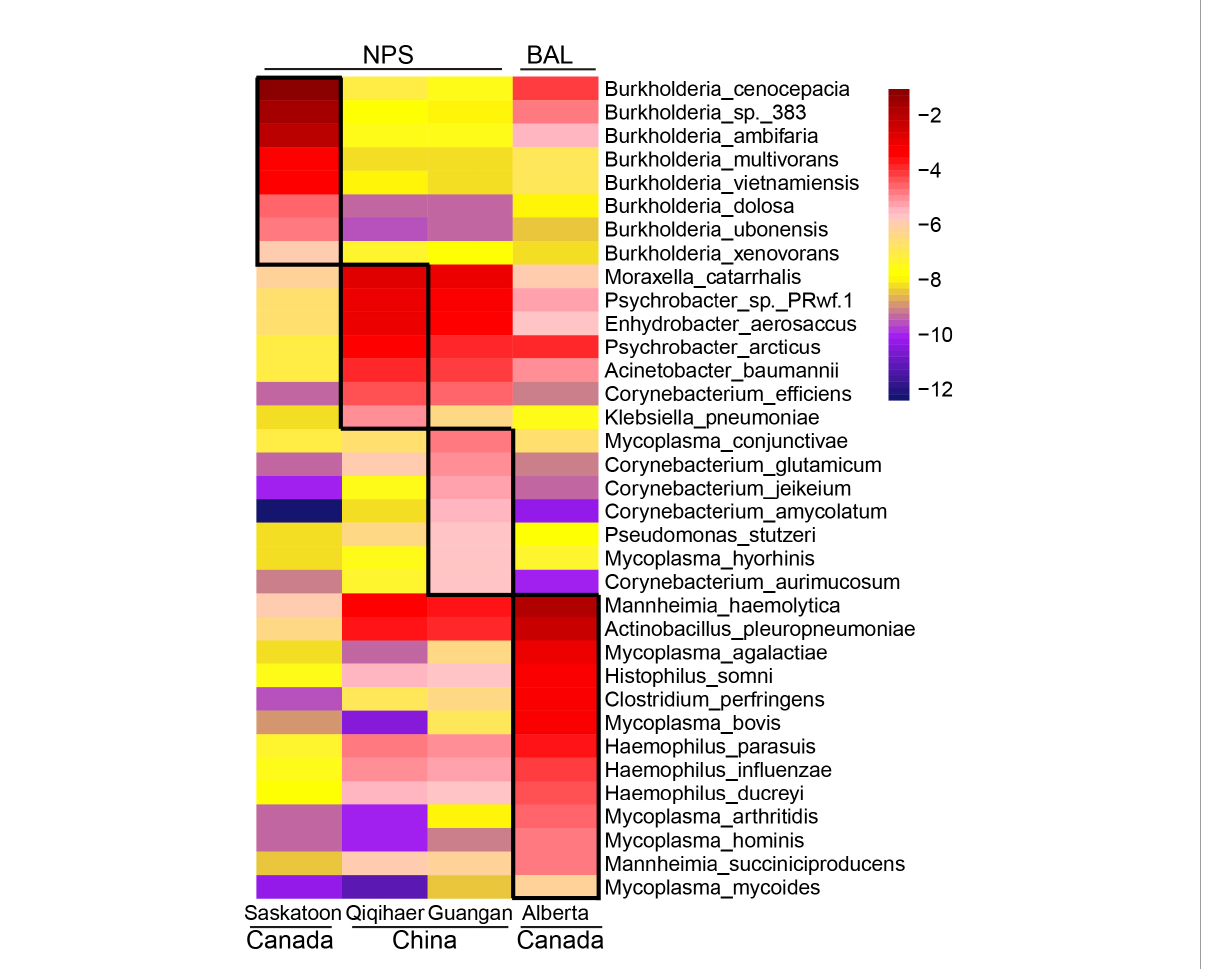
FIGURE 2 Geographic and niche-associated bacterial signatures that were identi fi ed by LEfSe analysis. The heat map shows the average relative abundance of ages on a log scale. The log-scaled relative abundance heat map of city-related bacterial species screened by LEfSe (linear discriminant analysis >2) in the bovine respiratory microbiome. The color of cells from purple to red corresponds to the relative abundance of bacteria from low to high. NPS, nasopharyngeal swab; BAL, bronchoalveolar